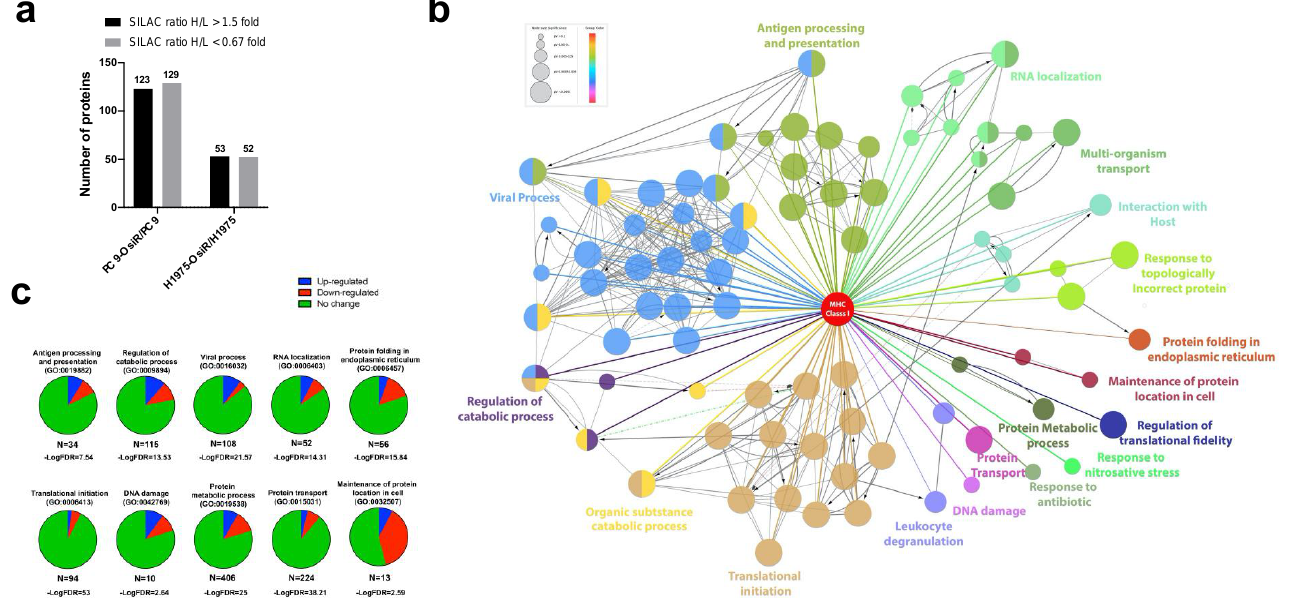
Figure 7. Altered interactome network analysis reveals possible signaling pathways involved in antigen processing and presentation upon osimertinib resistance. ( a ) SILAC-based quantitative interactome analysis unveils the up- and down- regulated association with HLA class I complex. ( b ) HLA class I-interactome network was generated using selected HCIs in PC9-OsiR/PC9 experiment. ( c ) Pie charts show the number of proteins differentially interacting with HLA class I complex in top 10 select GO annotated signaling pathways.